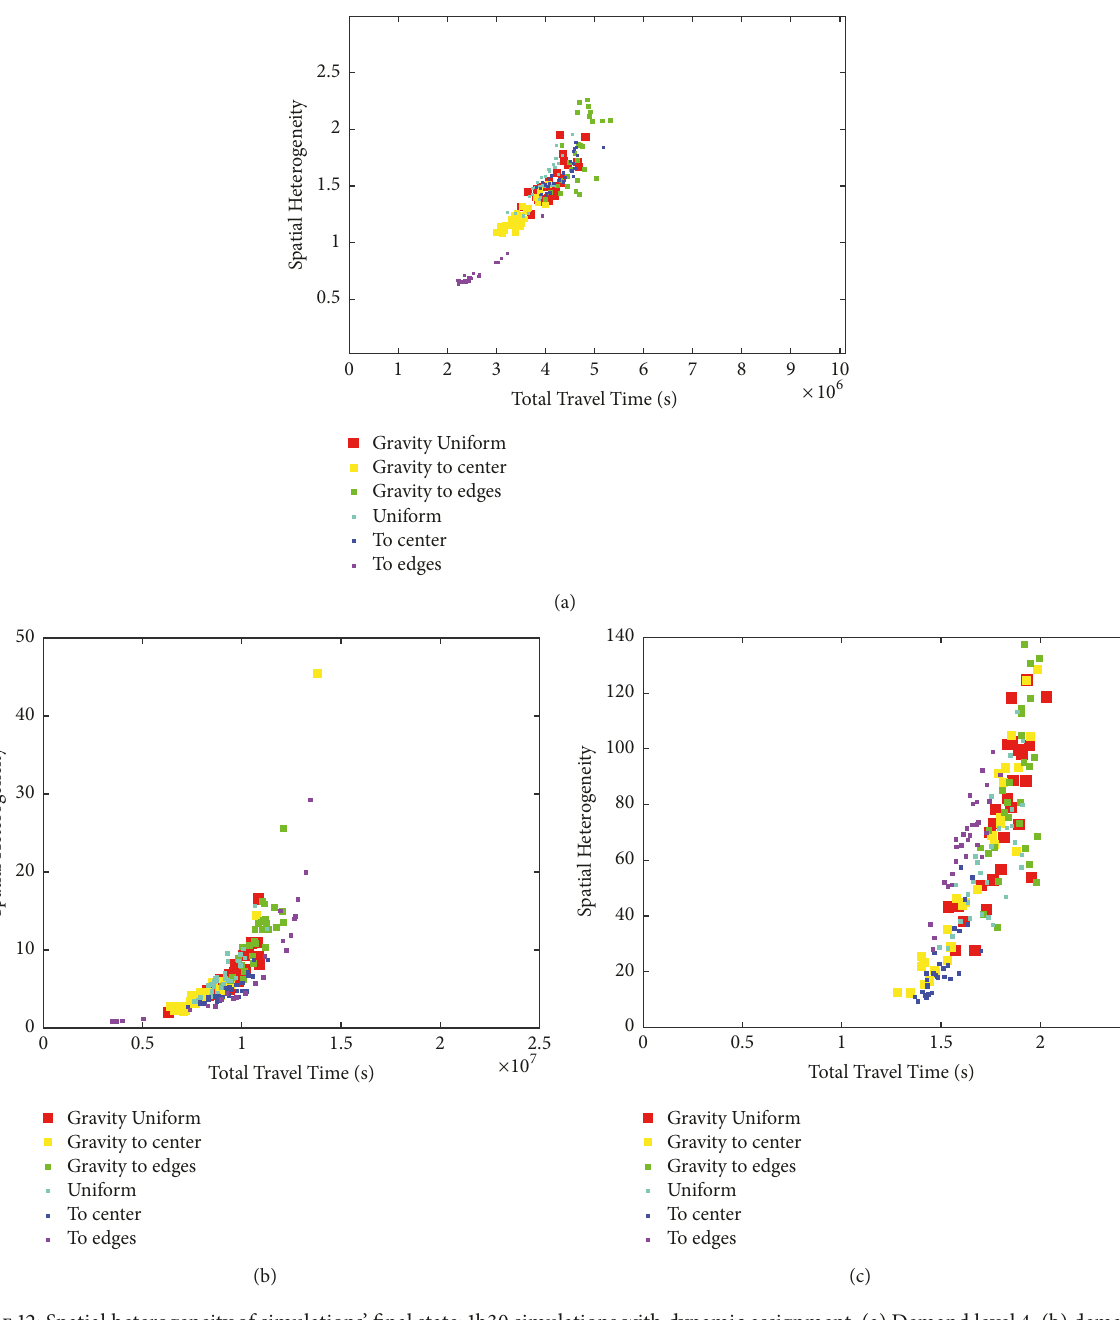
Figure 12: Spatial heterogeneity of simulations’ final state: 1h30 simulations with dynamic assignment. (a) Demand level 4, (b) demand level 5, and (c) demand level